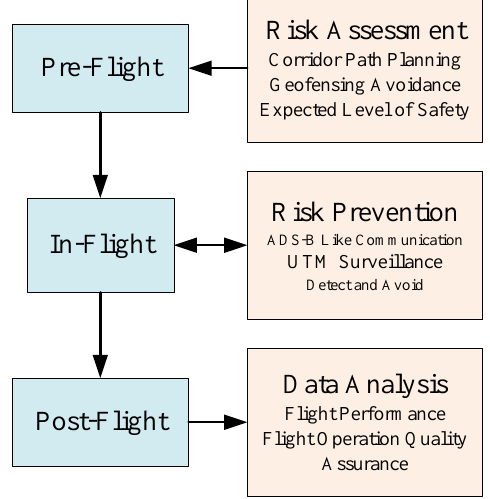
Figure 5. The concept of integrated UAV risk prevention system.